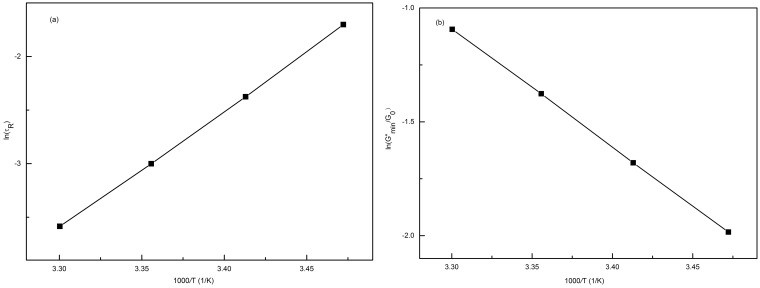
Energy calculation plots.(a) An Arrhenius plot of lnτ
R as a function of 1/T for the 70 mM C16MDB/40 mM SL solution; (b) the plot of ln (G″min/G0) as a function of 1/T.